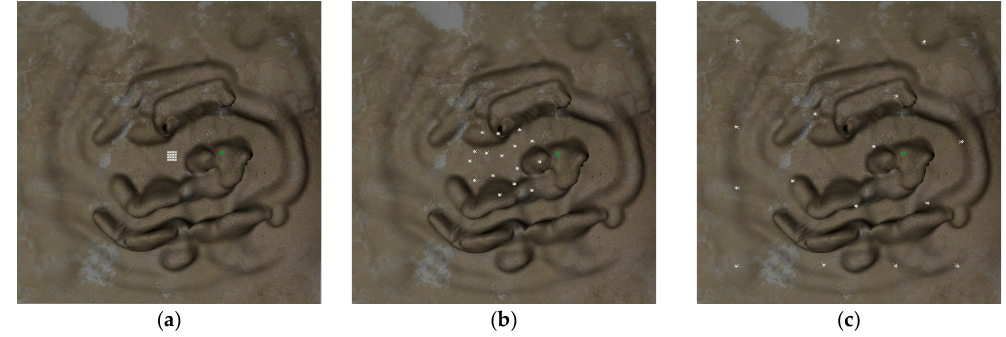
Figure 23. Three typical moments of multi-UAVs sensing coverage: ( a ) initial coverage ( 0 t ); ( b ) scatter moment ( 2 s t ); ( c ) steady-state coverage ( 10 s t ).